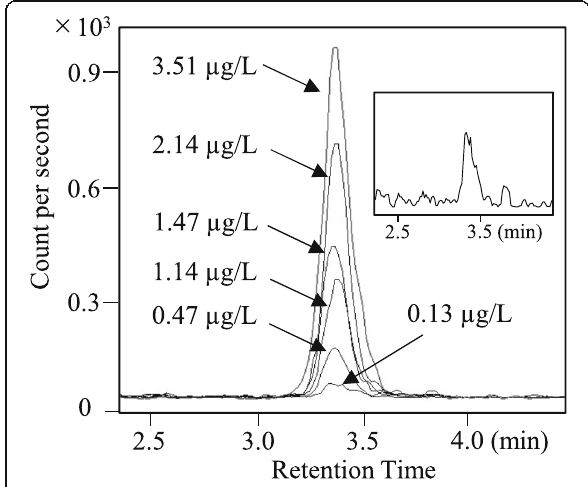
Fig. 3 Mass chromatogram of the glyphosate at concentration range from 0.13 to 3.51 μ g/L. The upper right chromatogram is the enlarged figure of the 0.13 μ g/L chromatogram